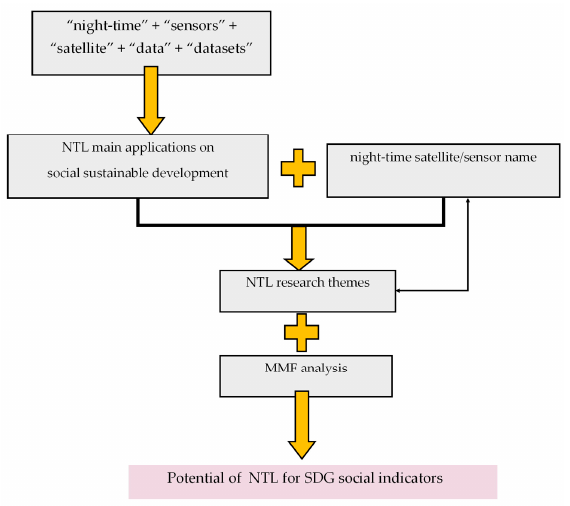
Figure 1. Flowchart of the NTL satellites for social indicators analysis.